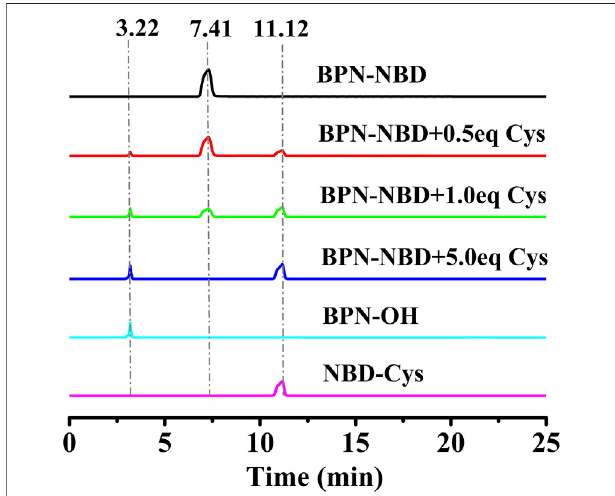
FIGURE3| TheUHPLCchromatograms:(black)BPN-NBD;(red/green/ blue) BPN-NBD with gradually increasing amount (0.5, 1.0, 5.0) equiv. of Cys incubated for 3 min; (cyan) BPN-OH; (magenta) NBD-Cys. Condition: eluent, H 2 O/CH 3 CN (v/v, 4/6), fl ow rate, 0.3 ml/min; temperature, 25 ° C; injection volume, 10.0 μ L.